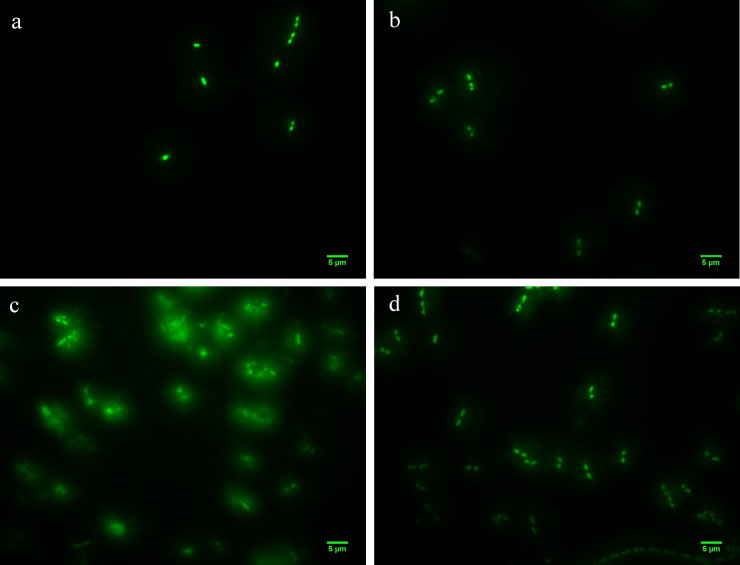
Bacteria morphology change during phage-induced lysis while co-incubating E. coli and T7 phages for 2 and 3 hours.a) cell morphology when co-incubating E. coli and T7 phages for 2 hours. b) cell morphology when incubating just E. coli for 2 hours. c) cell morphology when co-incubating E. coli and T7 phages for 3 hours. d) cell morphology when incubating just E. coli for 3 hours.